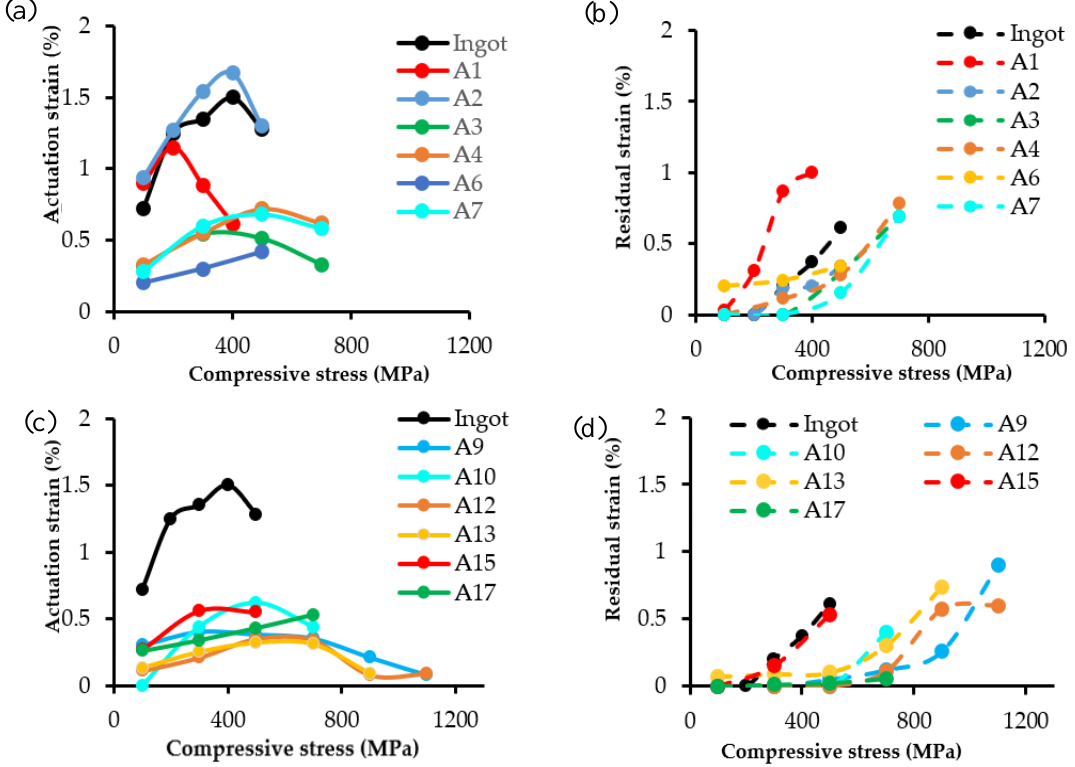
Figure 10. Actuation and residual strains as a function of compressive stresses for ( a,b ) samples with E below 100 J/mm 3 , and ( c,d ) E more than 100 J/mm 3 .